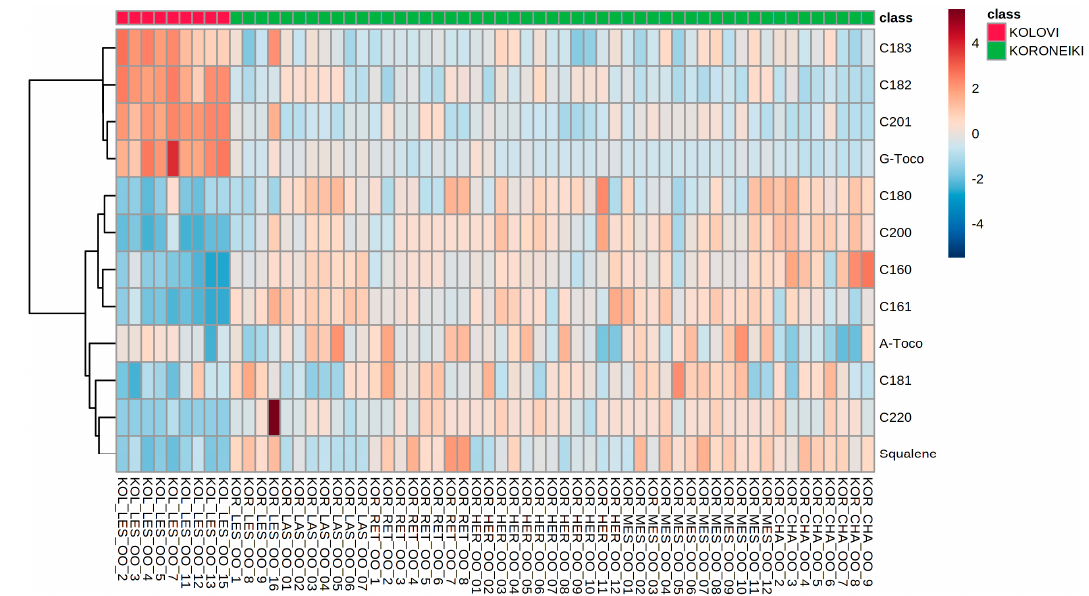
Figure 5. Clustering result of EVOOs by variety in the form of heatmap. The color scale on the right represents the normalized and scaled content of each variable, with red and blue-colored cells indicating high and low content, respectively.